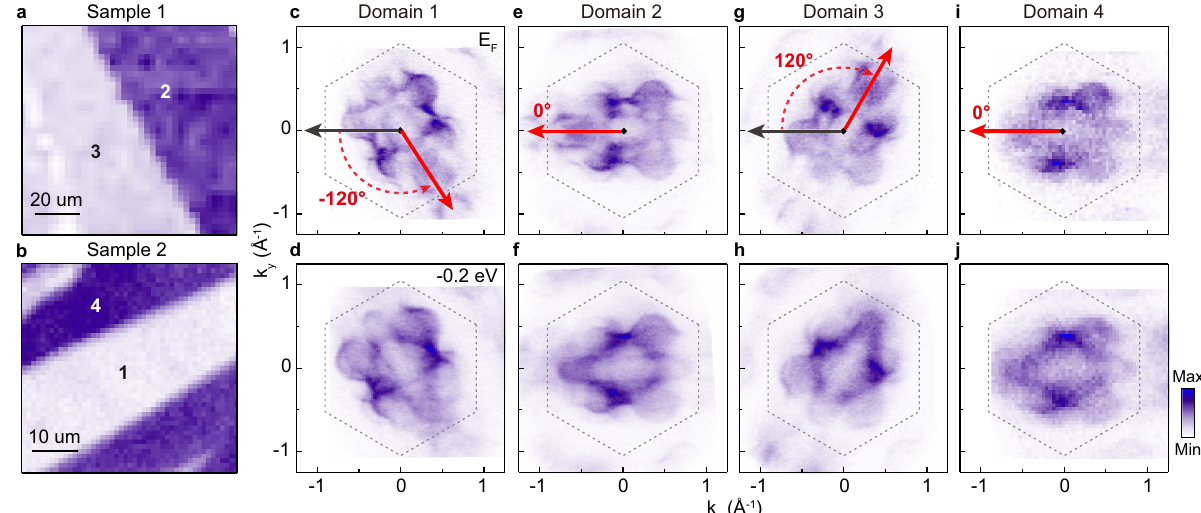
Fig. 2 Visualizing the stripe phases with three different orientations. a , b Spatially resolved intensity maps integrated over box 1 in Fig. 1d. c – j Fermi surface and intensity maps at − 0.2 eV of corresponding domains in panels a , b with Brillouin zone of 1 × 1 (gray